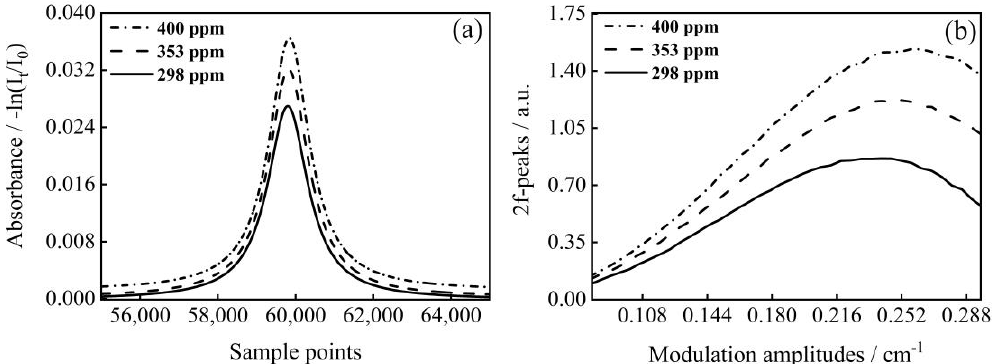
Figure 5. ( a ) Diagram of the experiment scheme; ( b ) Diagram of gas mixing system.